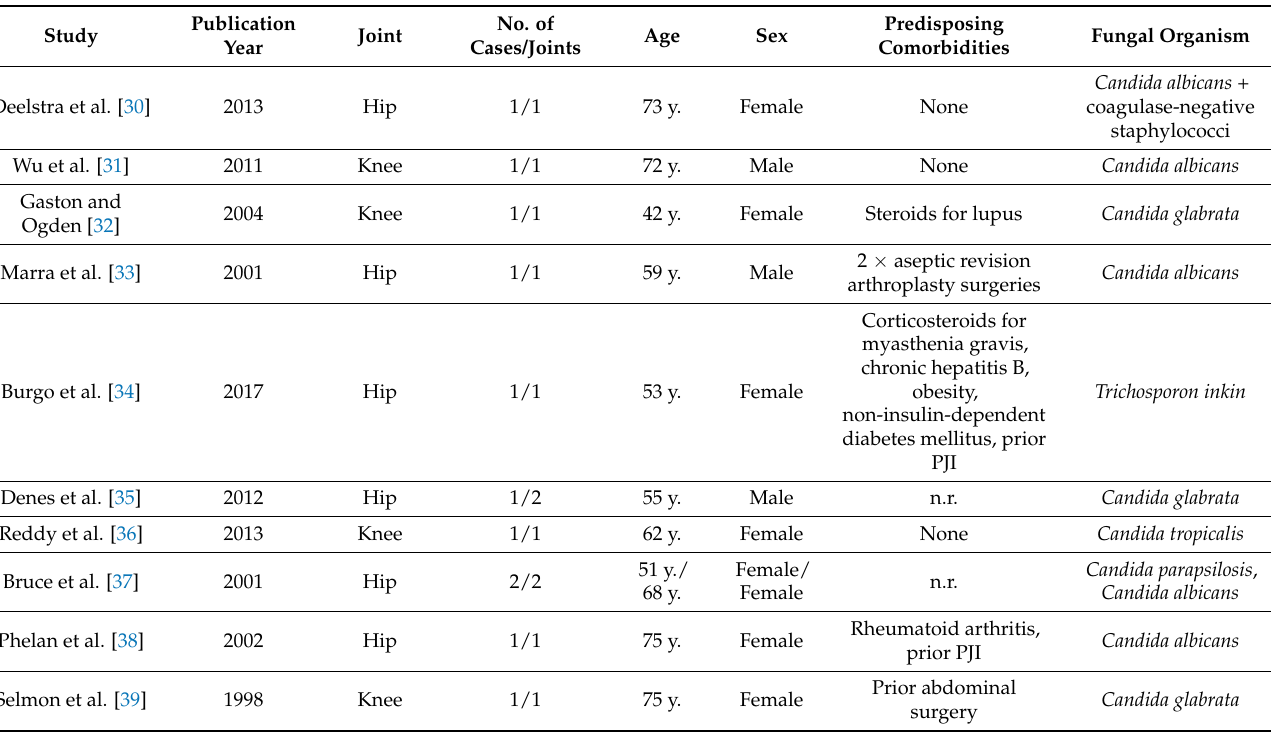
Table 1. Overview of treated cases, demographic data, predisposing comorbidities, and causative